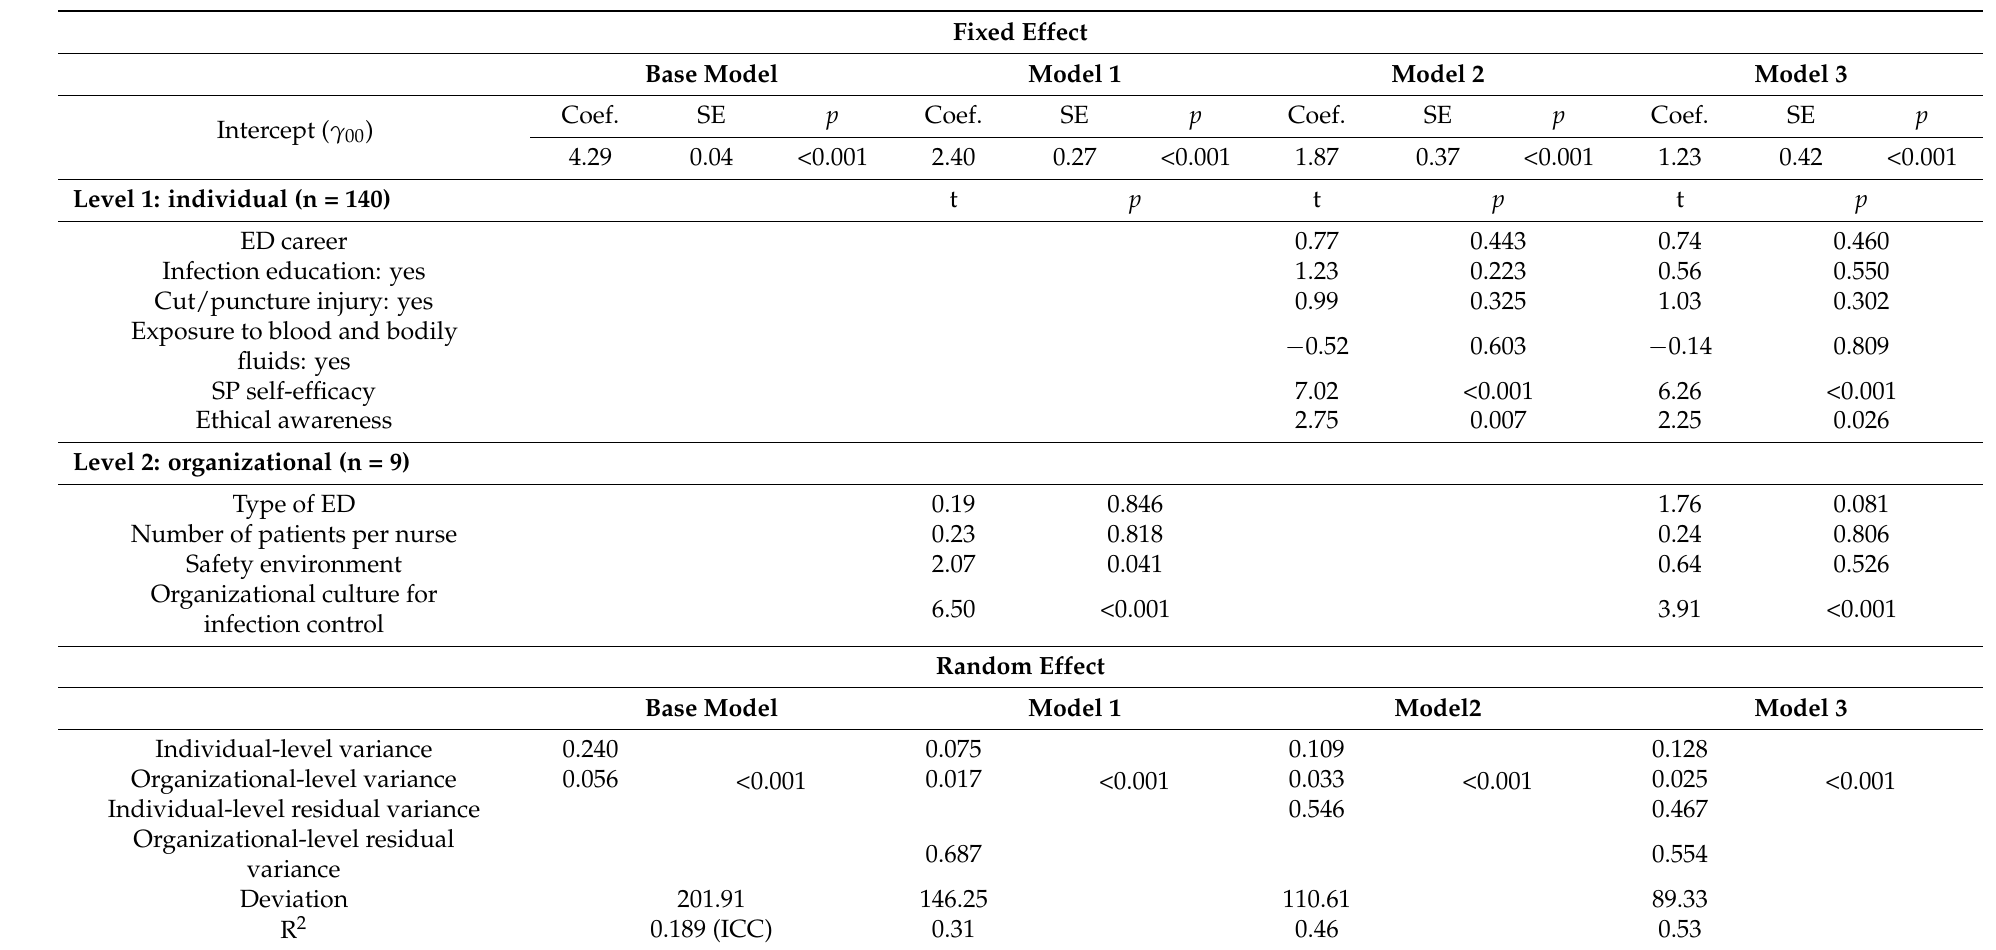
Table 4. Multilevel analysis of the predictors of compliance with